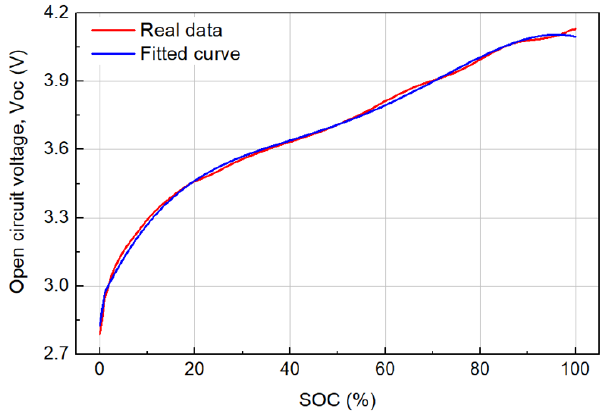
Figure 7. V OC and SOC curve of the LiB.